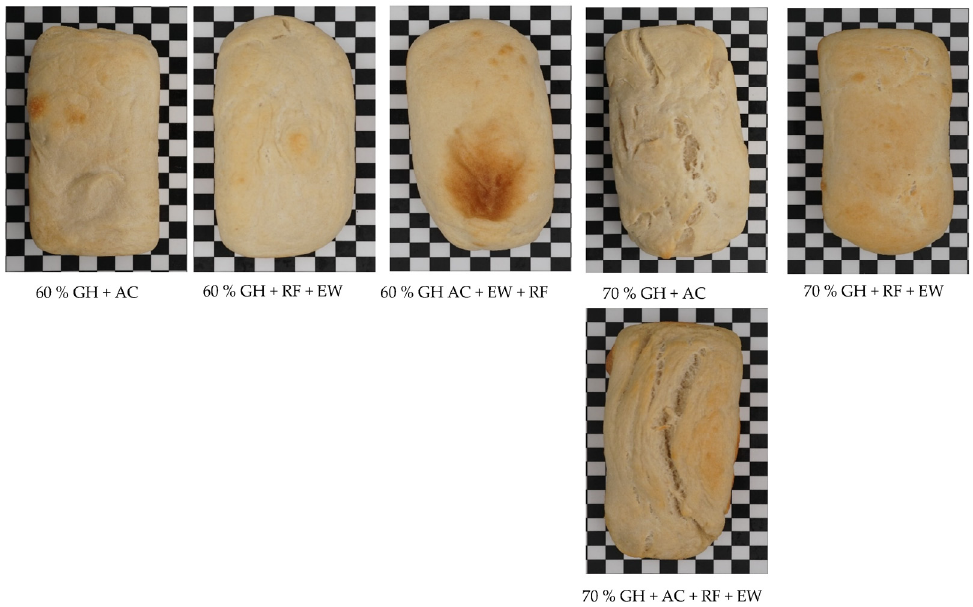
Figure 2. Pictures of GH bread (60 and 70% GH) with different gelling agents. The effect of gelling agents along with GH improved the physical appearance of the bread.